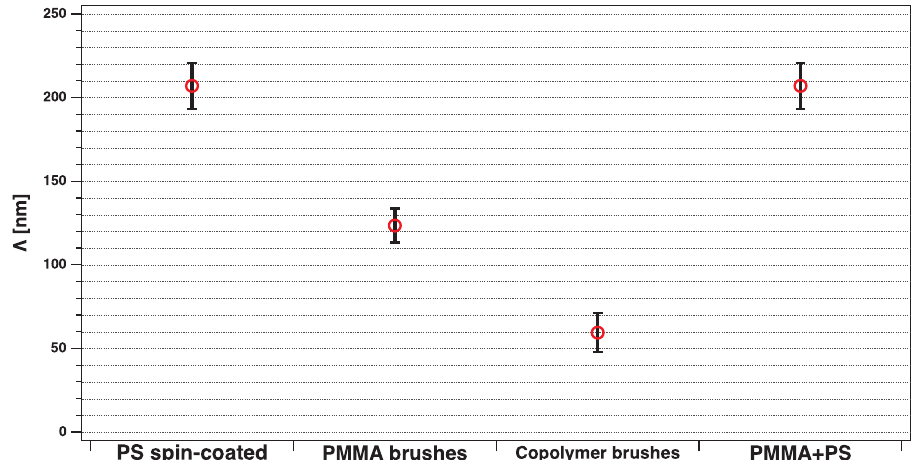
Figure 15. Lateral cutoff lengths for roughness correlation of correlated polymer thin